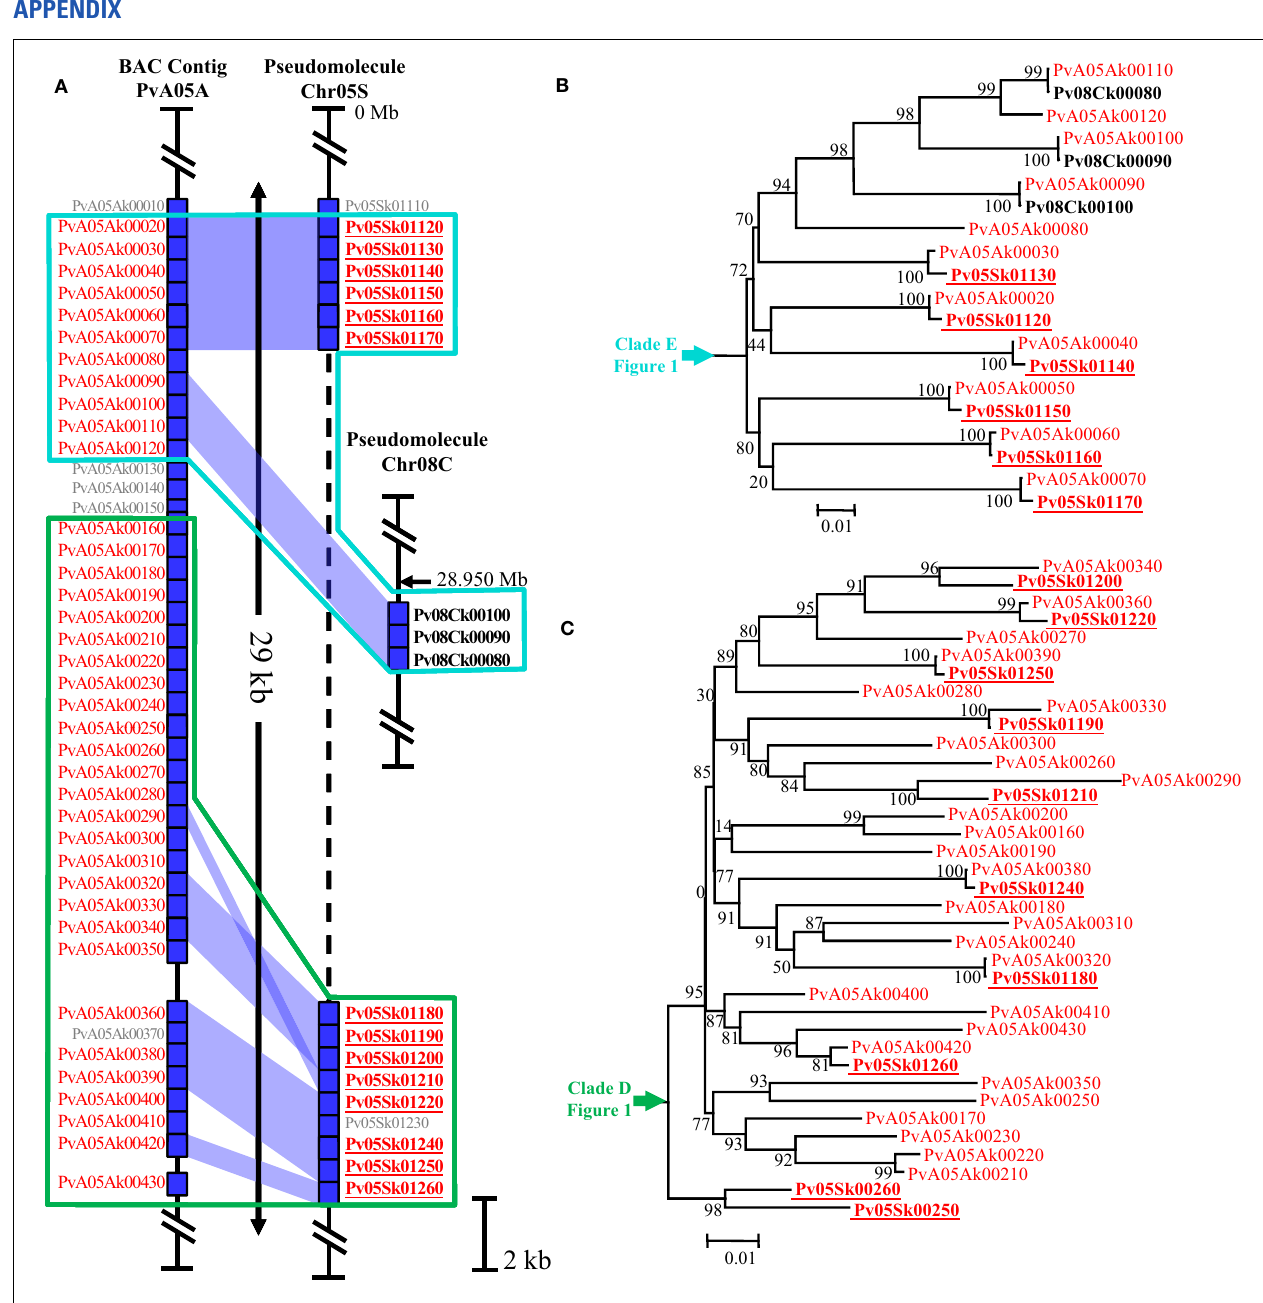
in red for khipu from PvA05A sequence, bold red and underlined for khipu from the pseudomolecule 5 and bold black for centromeric khipu of pseudomolecule 8. Khipu in small gray type correspond to khipu shorter than 500bp that were discarded from analysis.The blue area represents the correspondence between khipu from BAC sequence and khipu from genome sequence according to the phylogenetic tree. (B) and (C) Phylogenetic tree clades of khipu present on (A) . (B) Part of the clade called “E” ( cf . Figure 1 ) (C) Part of the clade called “D” (cf. Figure 1